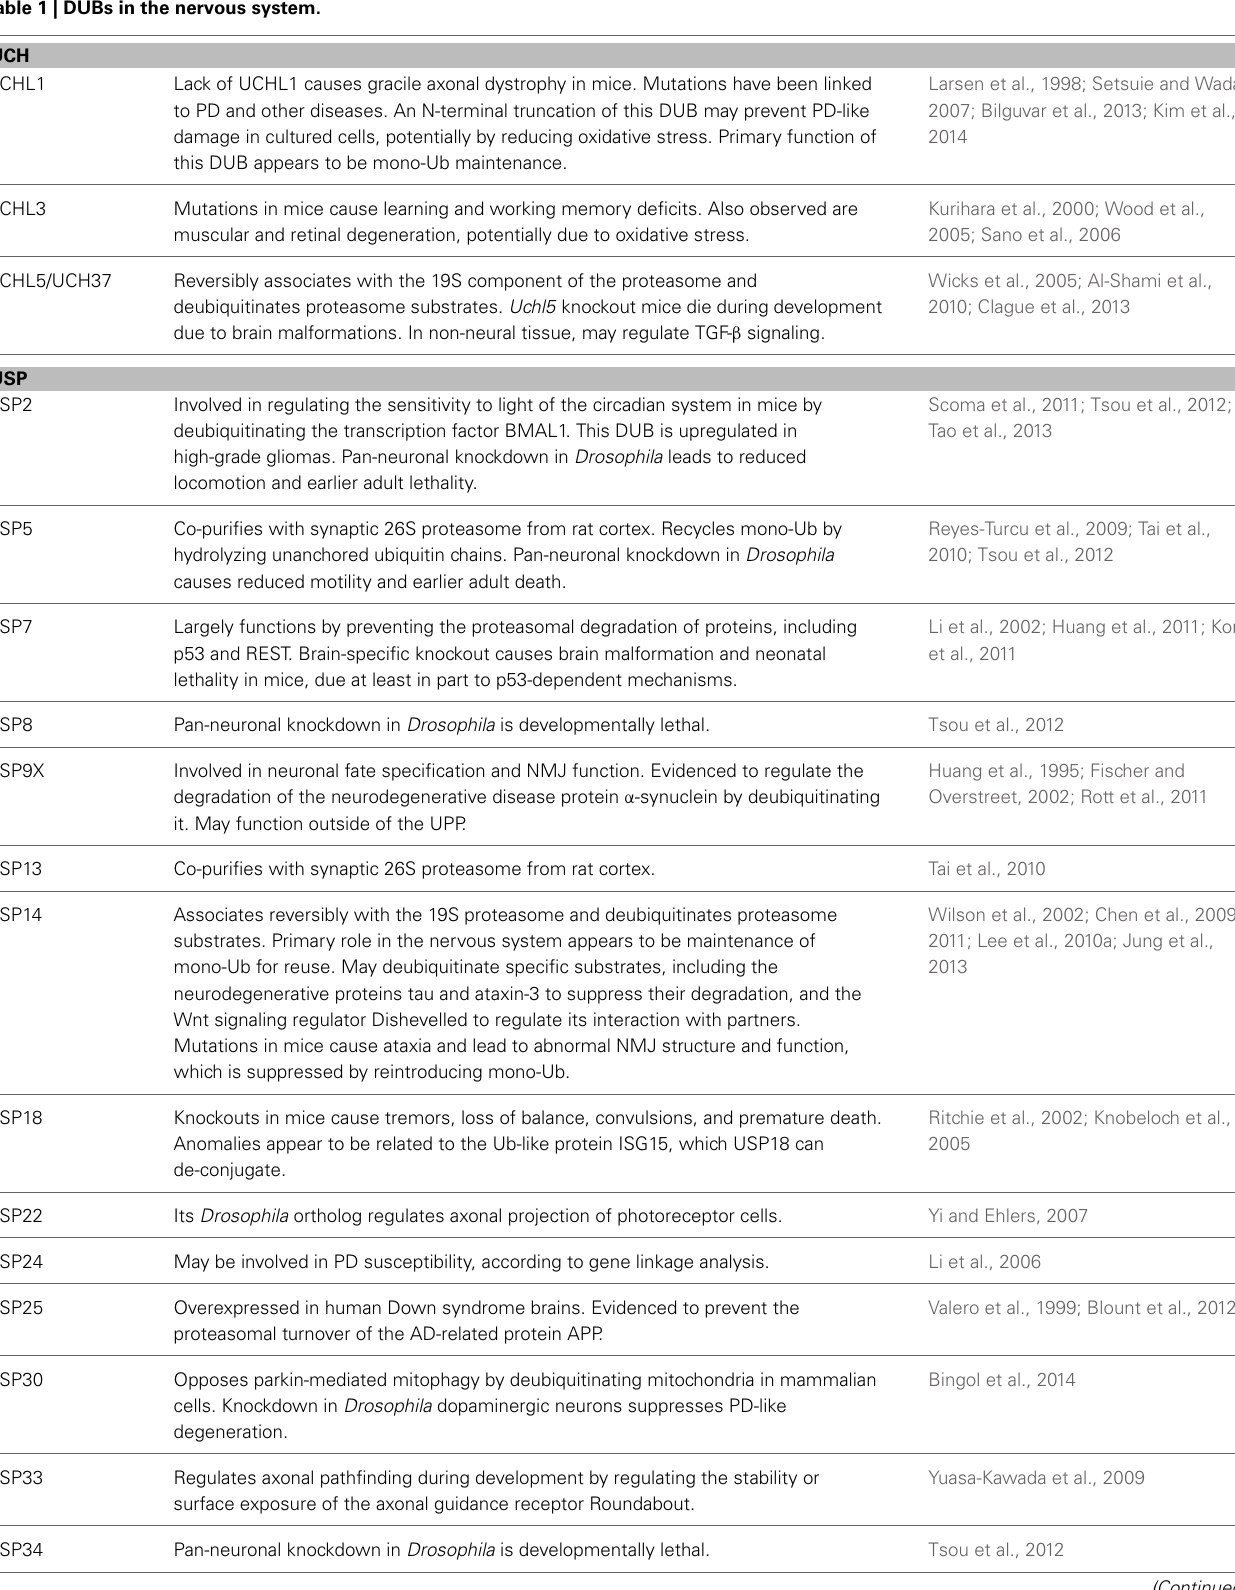
Table 1 | DUBs in the nervous